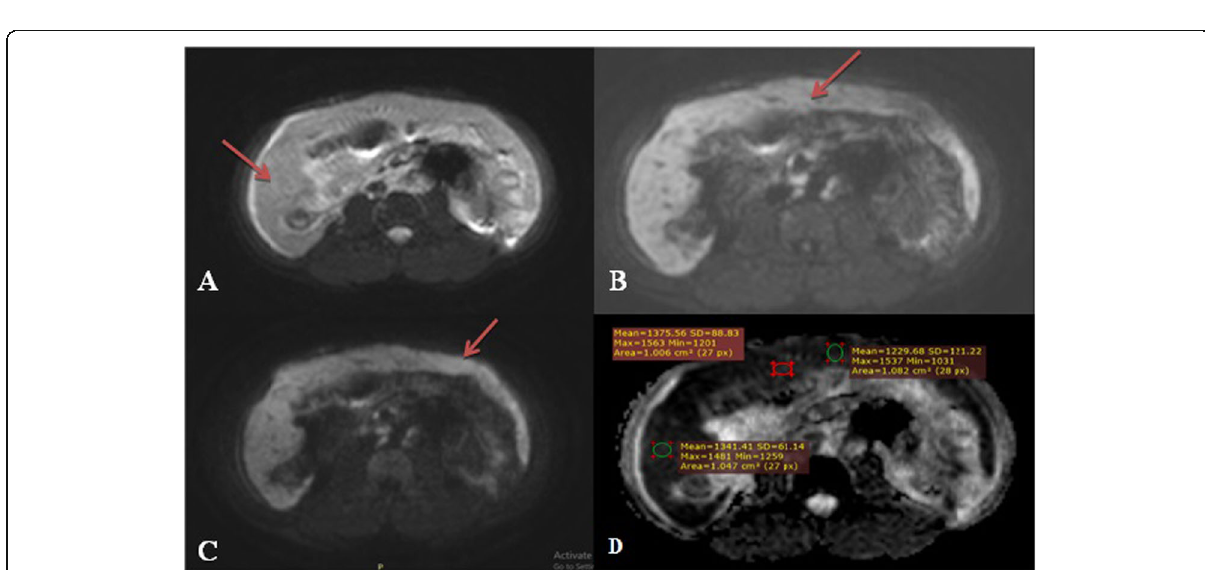
Fig. 4 Twenty-seven year old pregnant female patient with incidentally discovered abdominal mass during routine abdominal ultrasound. a Coronal T1 WIs. b Coronal T2 WIs. c DWI at b 1000. d ADC map. Note the gravid uterus associated with a solid peritoneal mass showing high signal in DWI and low in ADC map, impressive of restricted diffusion with average ADC value 1.14 ± 0.1 × 10 − 3 mm 2 /s. Final diagnosis